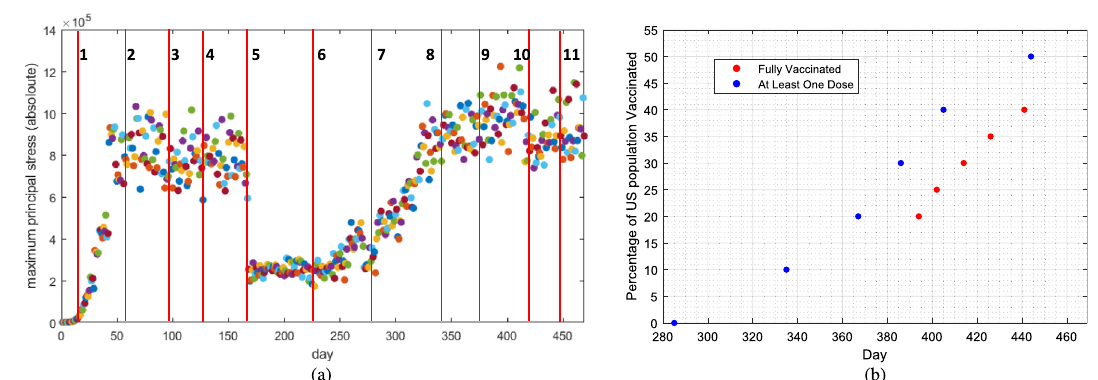
Figure 6. ( a ) Daily time-series related to cluster j ∈ C and m = | C | = 2 of maximum values of principal stresses of σ 1, s , j , σ 2, s , j , and σ 3, s , j for every active node. The vertical lines (from 1 to 11) represent the time of dynamics change in the pandemic evolution. ( b ) Percentage of US population Vaccinated based on time